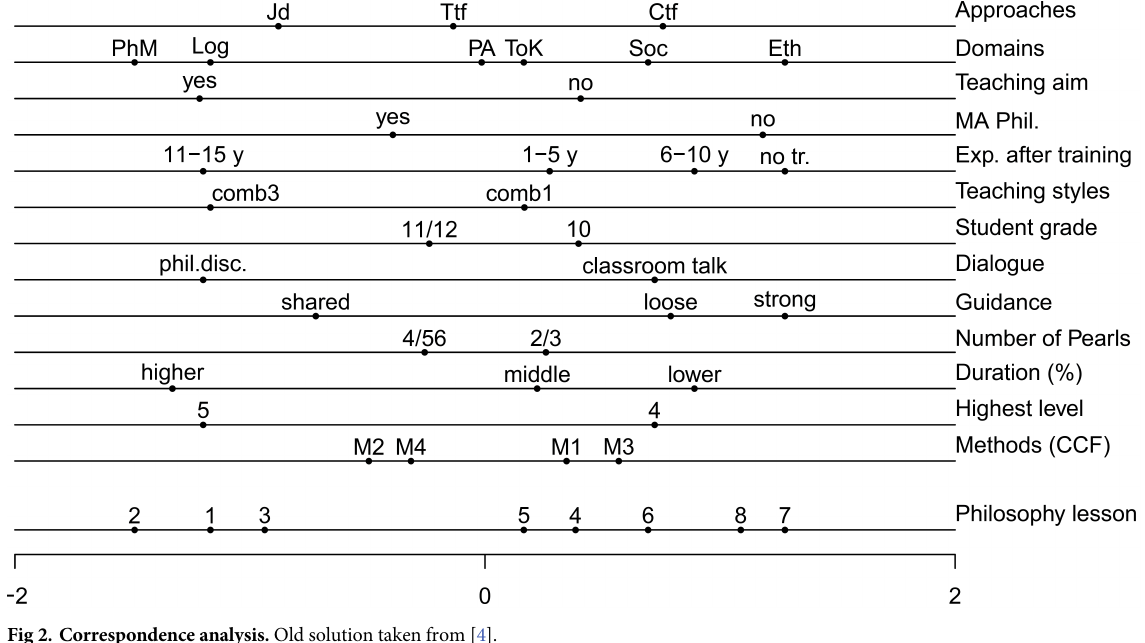
Fig 2. Correspondence analysis. Old solution taken from [4].